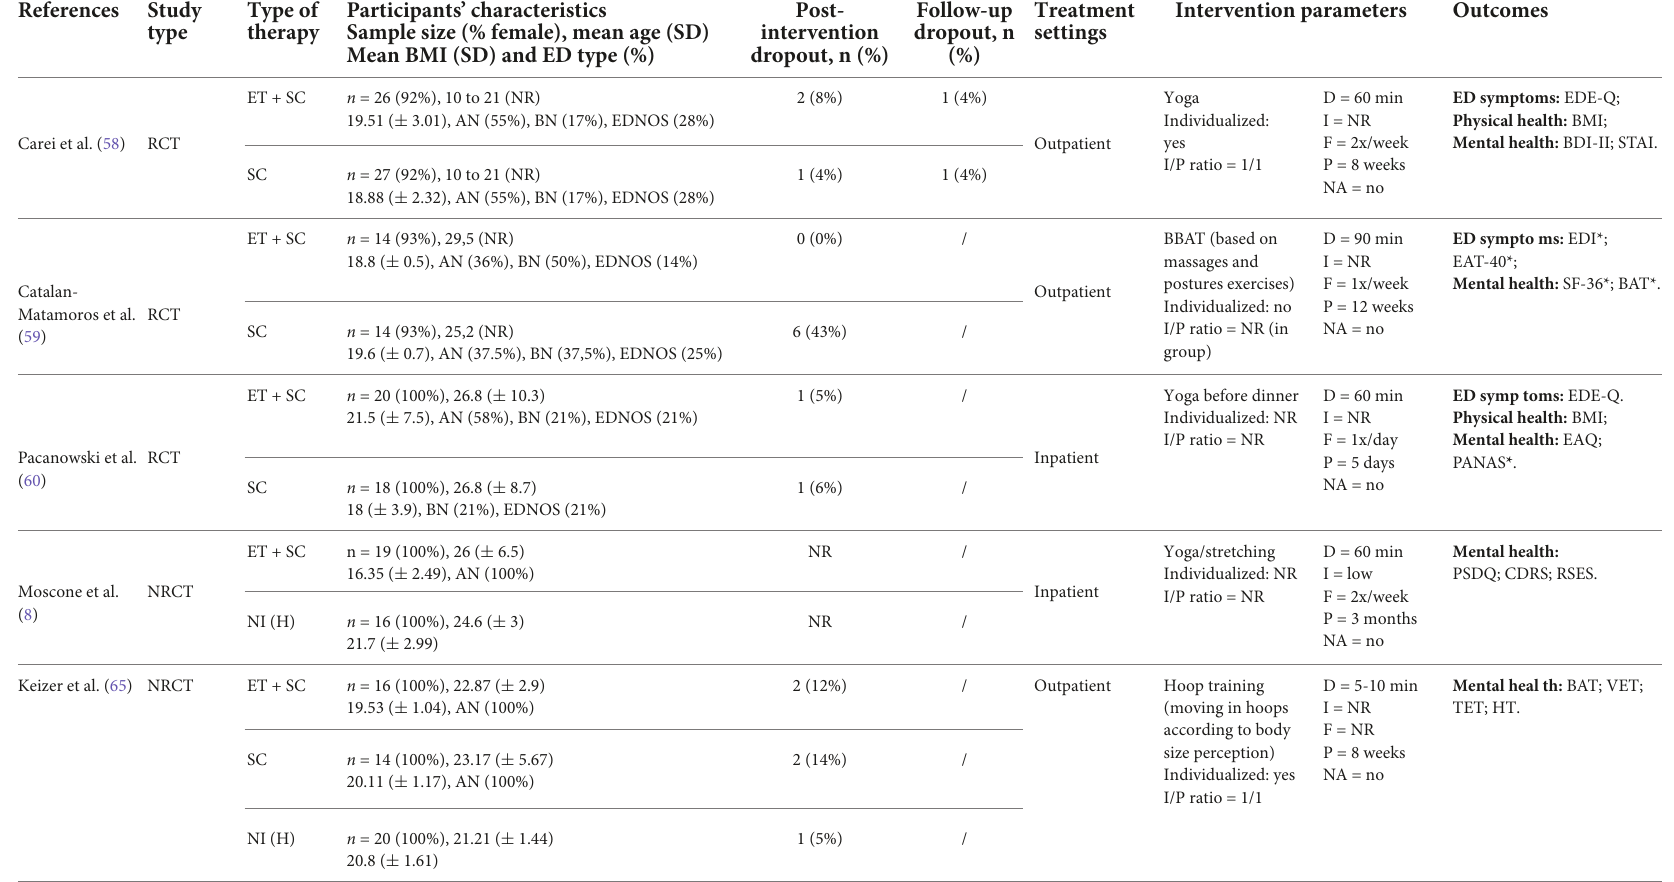
TABLE 5 Characteristics and main results of studies (RCT, NRCT, UT) conducted on effects of mind-body physical exercise in patients with